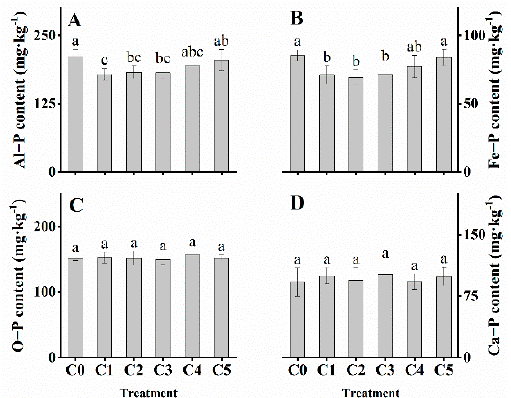
Figure 4. Amounts of rhizosphere soil inorganic P in Al − P ( A ), Fe − P ( B ), O − P ( C ), and Ca − P ( D ) fractions with different treatments. Al − P, Fe − P, and Ca − P refer to P in the fractions bound with Al, Fe, and Ca, and O ‐ P to the occluded fractions. Different letters above columns indicate significant differences among treatments tested by one ‐ way ANOVA ( p < 0.05).